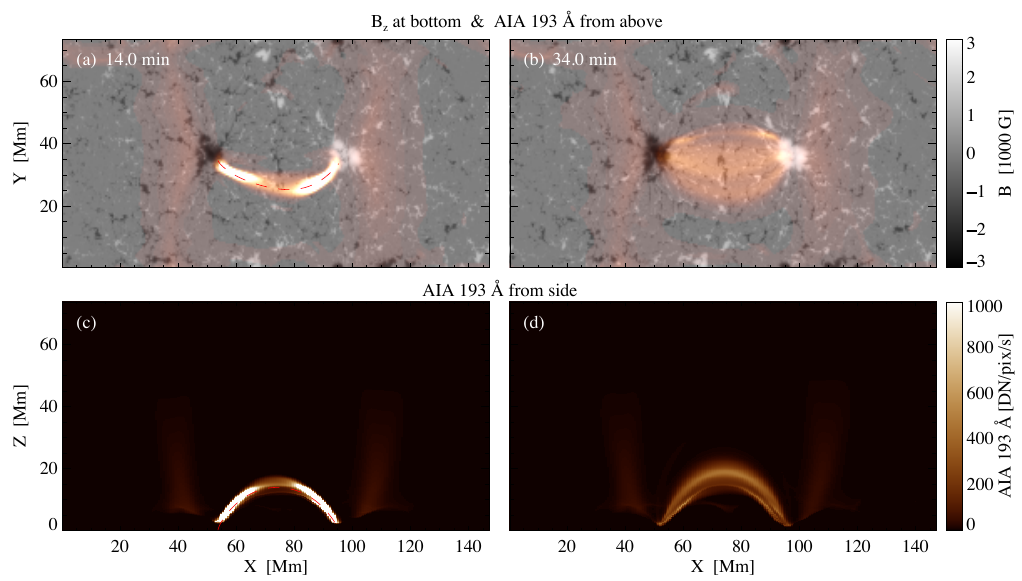
Figure 62: This model of the formation of AR corona by Chen et al. (2014) is driven at the bottom boundary ( 𝑧 = 0) by a radiative MHD simulation of AR-scale flux emergence (Rempel and Cheung, 2014). The greyscale in panels (a) and (b) shows synthetic magnetograms at the photospheric layer. The yellow shading in all four panels shows EUV images of AR coronal loops synthesized for the 193 ˚A channel of SDO/AIA. Image reproduced with permission from Chen et al. (2014), copyright by ESO.